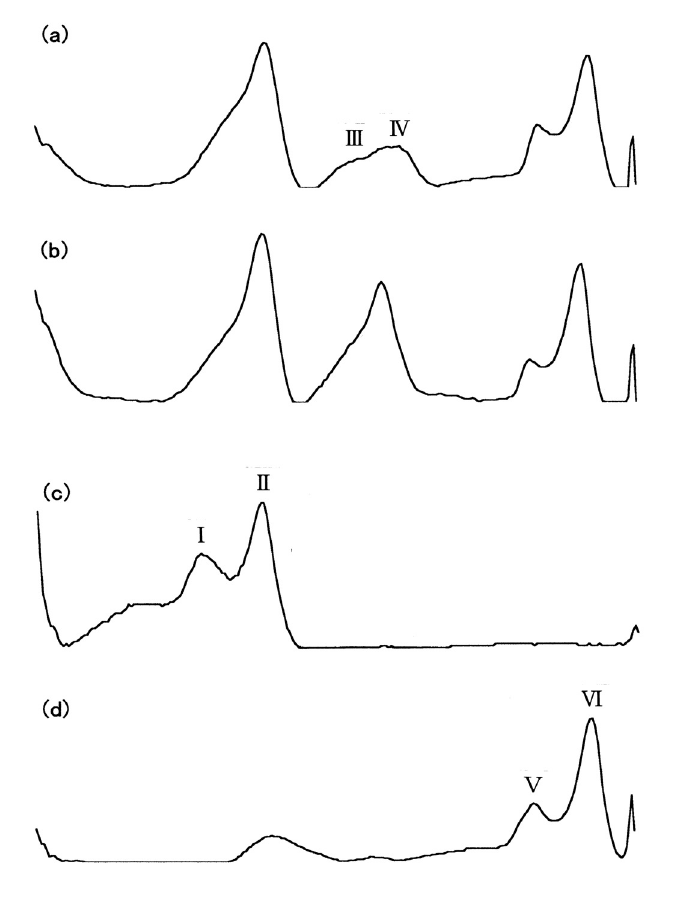
Figure 10. Densitometric profiles of polyacrylamide gel electrophoresis for qualified samples. Densitometric changes correspond to: ( a ) initial HbO sample; ( b ) partially (50%) 2 oxidized sample; ( c ) isolated α chain sample as an endpoint product and ( d ) isolated β SH SH chain sample as the other endpoint species. The isolated chains ( α and β ) were completely SH SH converted to the ferric met form by addition of potassium ferricyanide. Thereafter, the chain-separation procedure was carried out for the initial HbO sample and partially (50%) 2 oxidized sample.